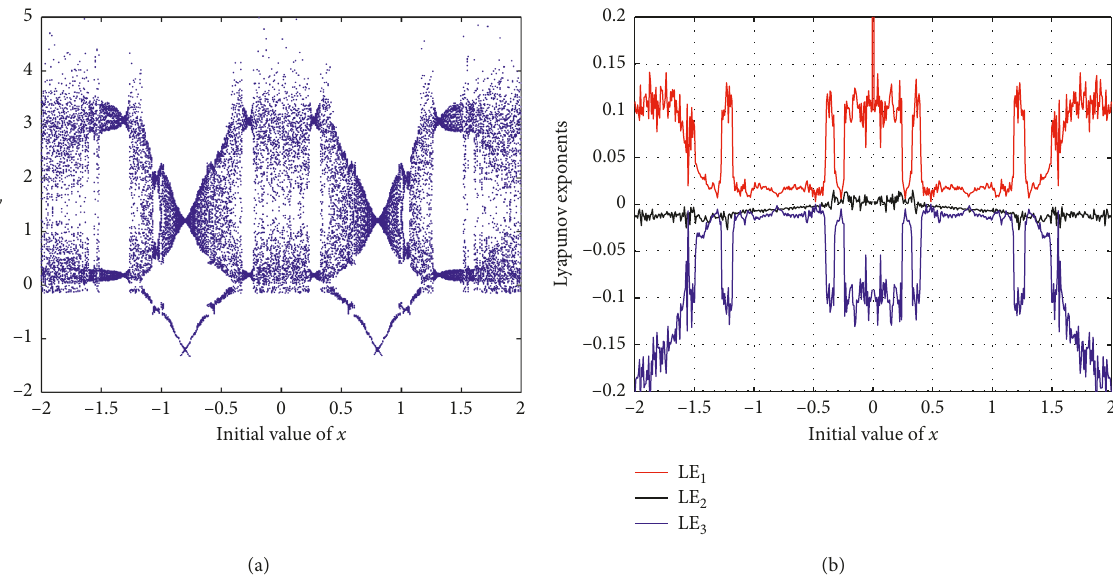
Figure 5: (a) Bifurcation diagram; (b) Lyapunov exponent spectrum versus x ( 0 ) .